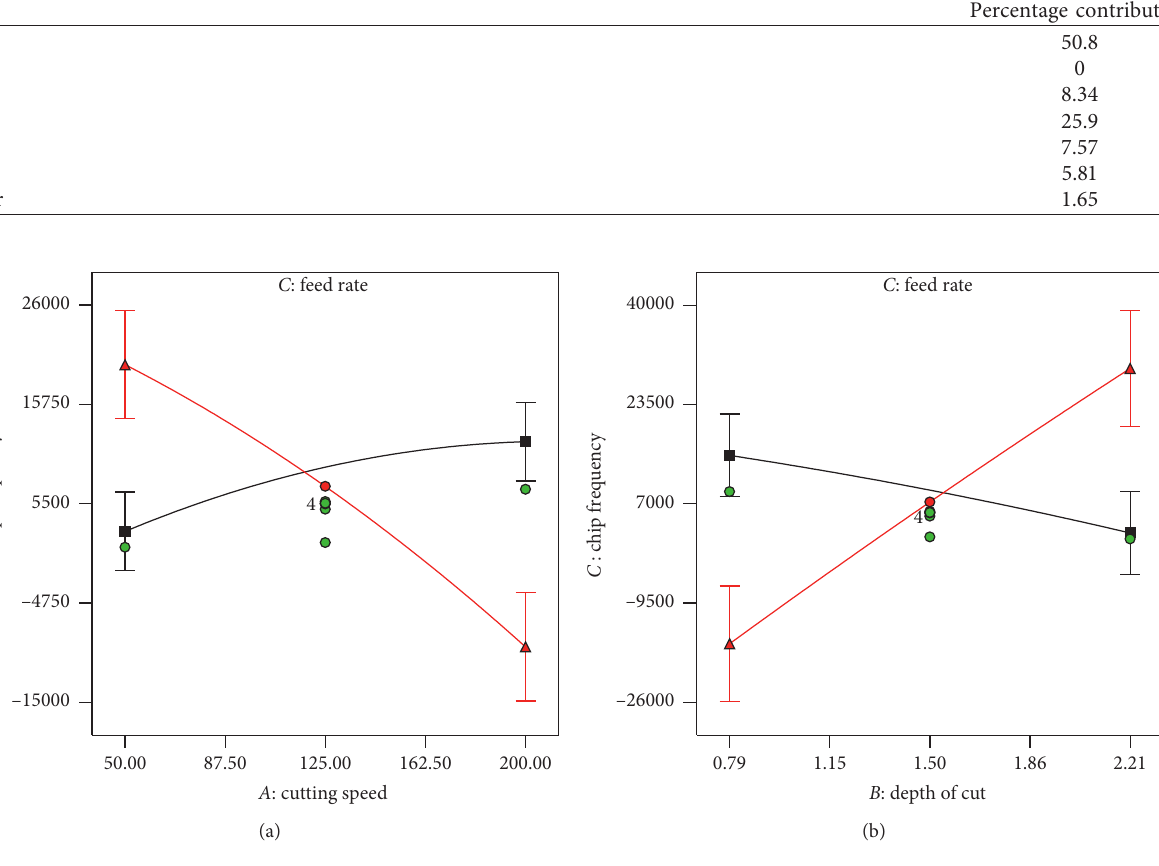
Table 8: Percentage contribution for chip frequency.